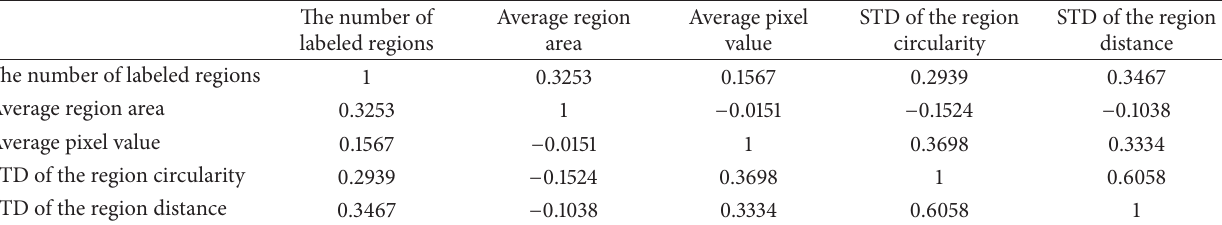
Table 2: The estimated correlation coefficient among different